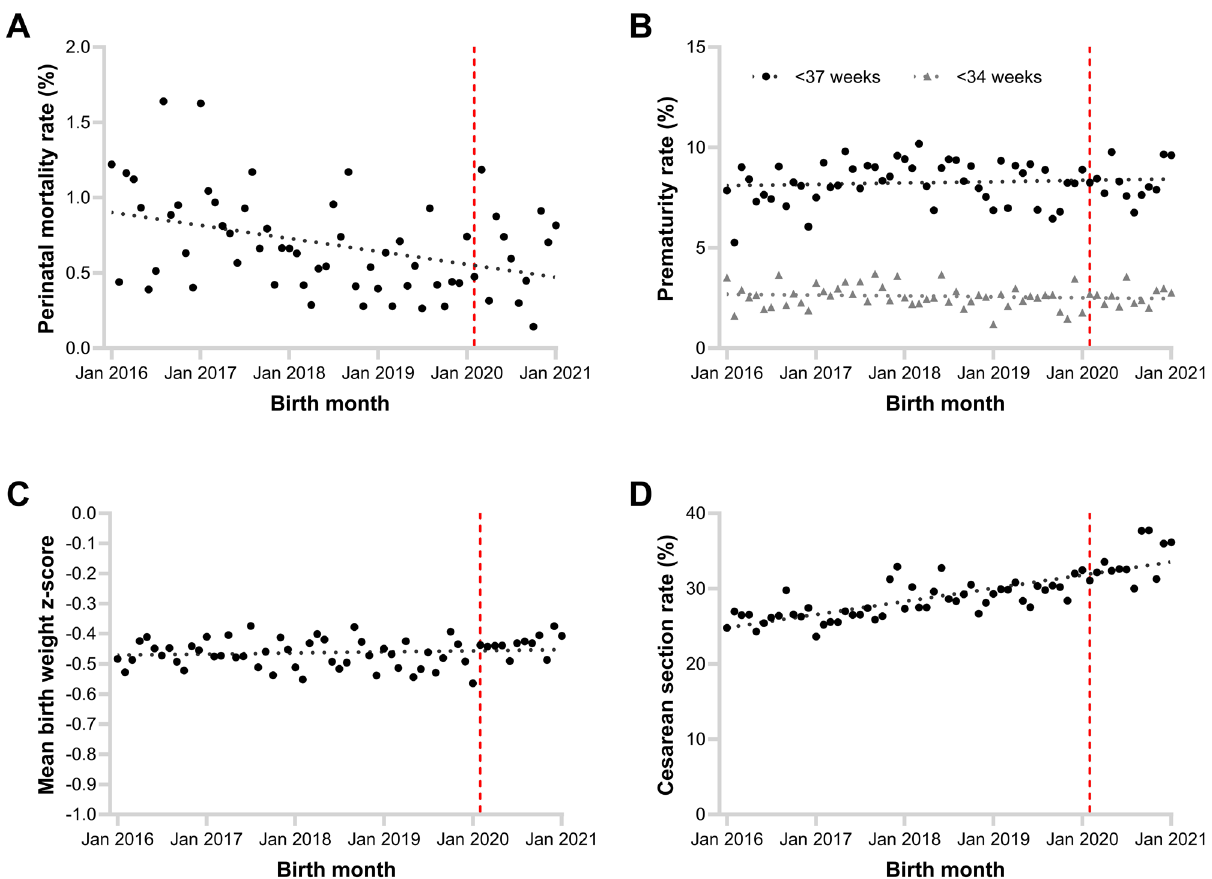
Figure 1. Changes in pregnancy outcomes over time. Scatter plots show ( A ) extended perinatal mortality rate including stillbirth and neonatal death, ( B ) rates of preterm birth at < 37 and < 34 weeks, ( C ) birth weight adjusted for gestation using z-score, and ( D ) caesarean section rate by month of birth between January 2016 and January 2021. Dotted lines are simple linear regressions of the presented data points, and the vertical dashed lines represent the start of the COVID era on 17 February